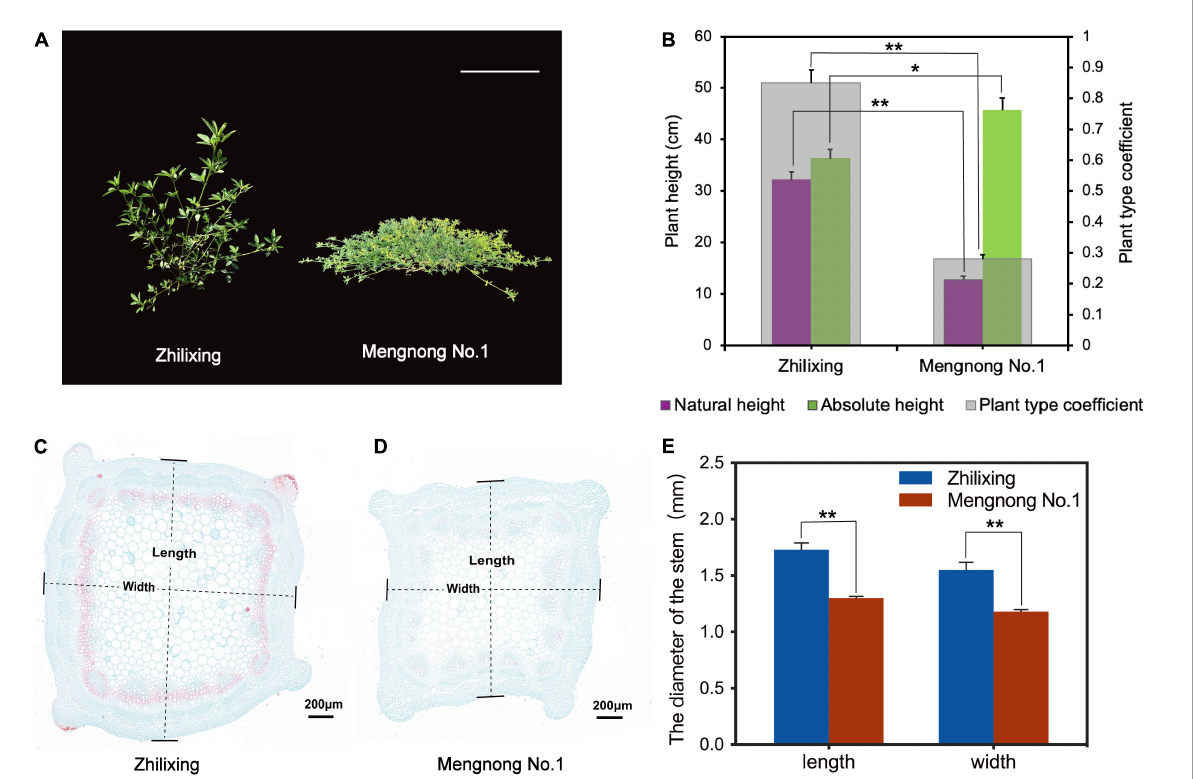
FIGURE1 Phenotypic analysis of M. ruthenica cultivars Zhilixing and Mengnong No.1. (A) Two-month-old plants of the Zhilixing and the Mengnong No.1. Bar = 10 cm. (B) Comparison of the plant height (absolute plant height and natural plant height) and plant type coefficient between the two cultivars. The plant type coefficient was calculated by the ratio plant type coefficient = natural height/absolute height. A plant type coefficient less than 0.5 indicates a prostrate stem, greater than 0.8 indicates an erect stem, and 0.5–0.7 indicates an oblique stem. Values are means ± S.D. of fifteen biological replicates. (C–E) Stem cross section of the Zhilixing (C) and the Mengnong No.1 (D) . Lignified cells appear in red color. Stem (internodes 4–6) from the same period as (A) at 5.0x magnifications. Bar = 200 µ m in (C,D) . (E) The stem diameter was measured according to the “length” and “width” of (C,D) labels. Values are means ± S.D. of six technical replicates (different paraffin sections) from three biological replicates. In (B,E) , asterisks indicate significant differences between the two cultivars, as determined by Student’s t -test (** p < 0.01, * P <